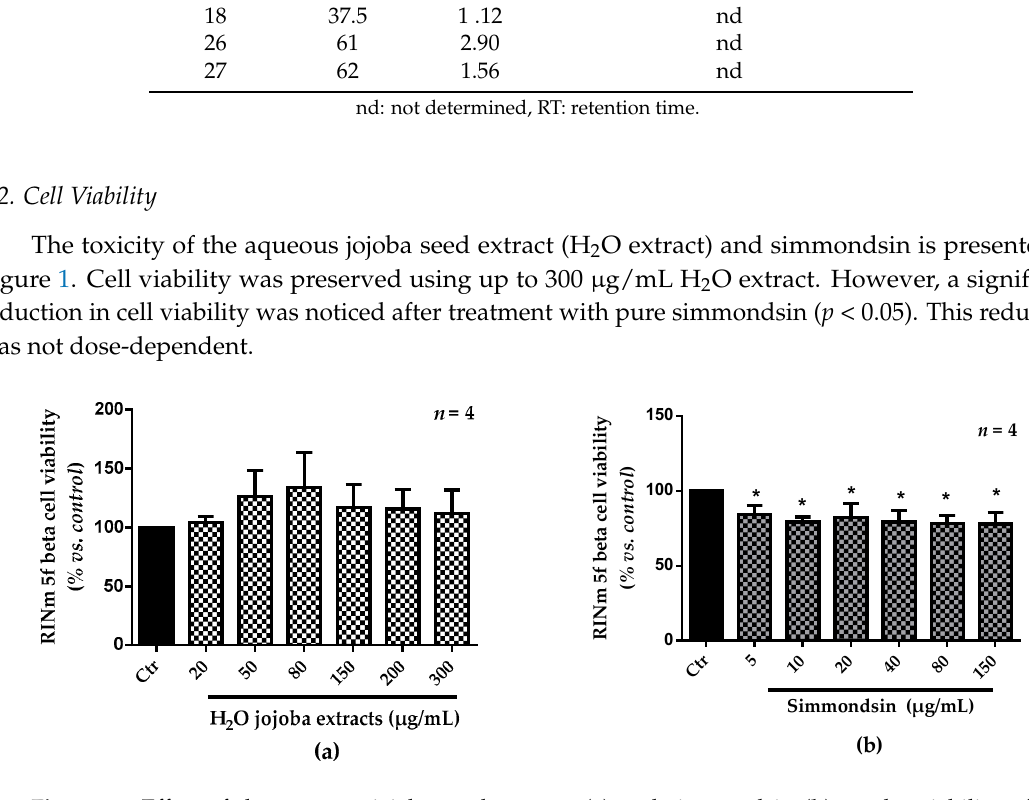
Figure 1. Effect of the aqueous jojoba seed extracts ( a ) and simmondsin ( b ) on the viability of RINm5f beta cells at different concentrations. Each value represents the mean ± standard error of the mean (SEM) of three independent experiments in triplicate. * p < 0.05, compared to untreated cells. Ctr: control.